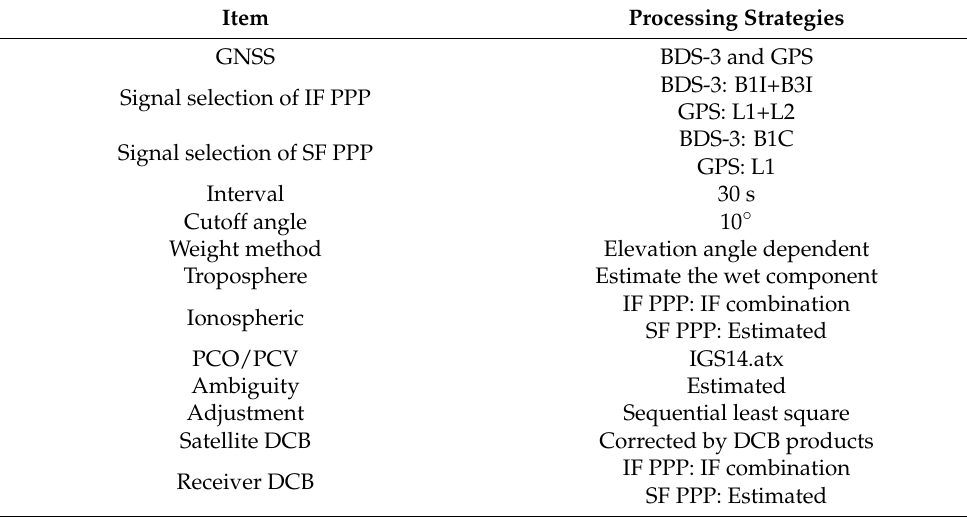
Table 3. PPP processing strategies of static test.